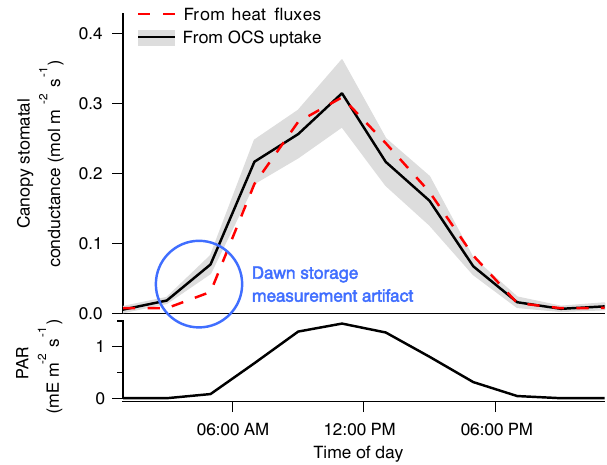
Figure 12. Composite diel cycles of stomatal conductance derived from the OCS uptake (solid black line with gray bands) and from the sensible and latent heat fluxes (red dashed line), along with pho- tosynthetically active radiation (PAR, bottom panel) for context, in- cluding May through October of 2012 and 2013. Lines connect the mean values of each 2h bin. The gray bands depict standard er- rors in the means as estimated from the variability within each bin. Adapted from Wehr et al. (2017), which discusses the dawn storage measurement artifact indicated here by the blue